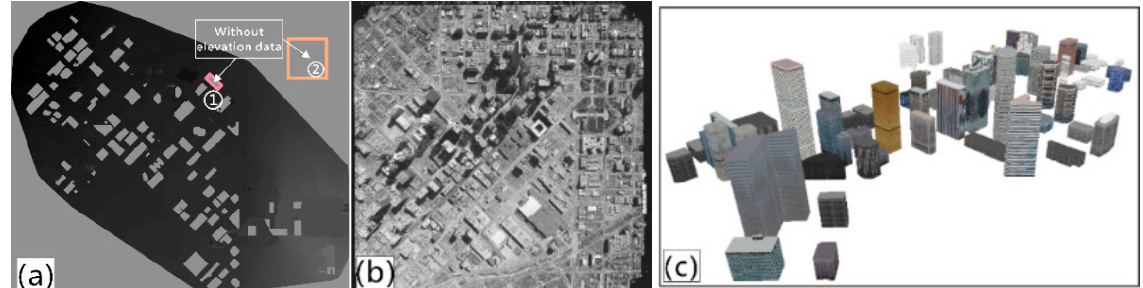
Figure 11. The experimental Dataset 1. ( a ) DTM data, where area ① and ② represent areas without elevation data; ( b ) Aerial image data; ( c ) DBM data.